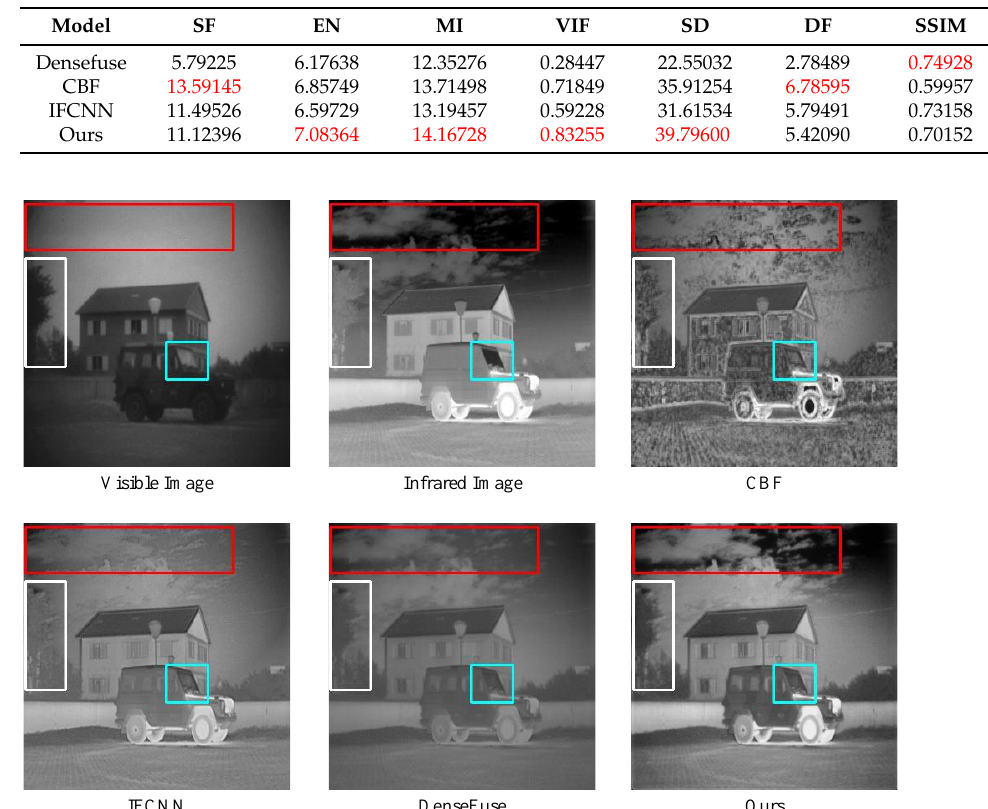
Table 4. The result of TNO datasets.